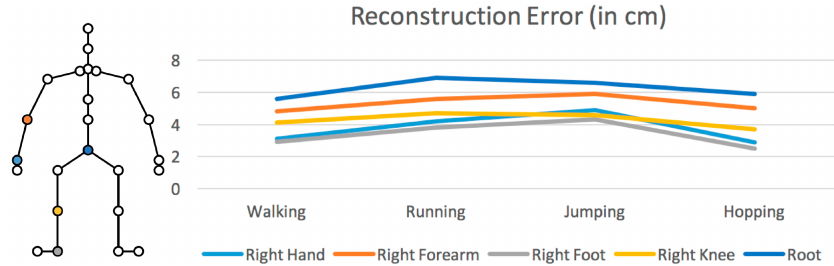
Figure 10. The position of the IMU (left) and the reconstruction error when compared with the ground truth data (right).